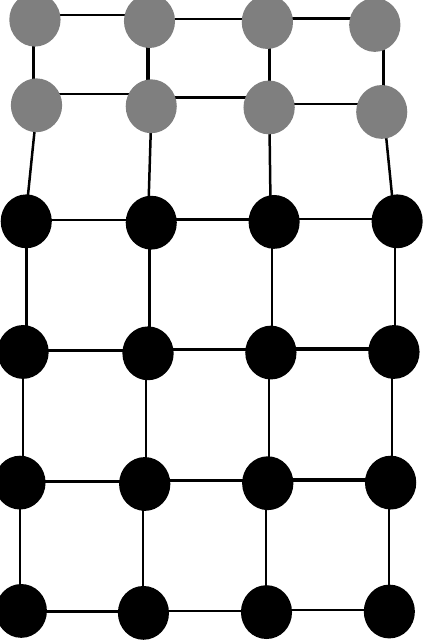
Figure 1. An illustration of residual stresses in thin-film layers deposited onto substrates. In this case, the thin film material layer would be in a state of tensile stress (with a positive sign).